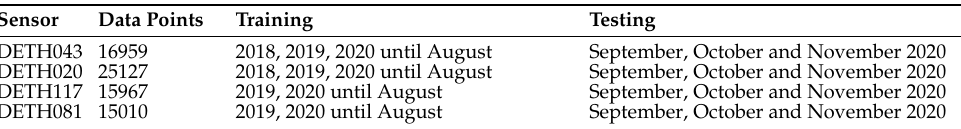
Table 2. Training and testing period per sensor.